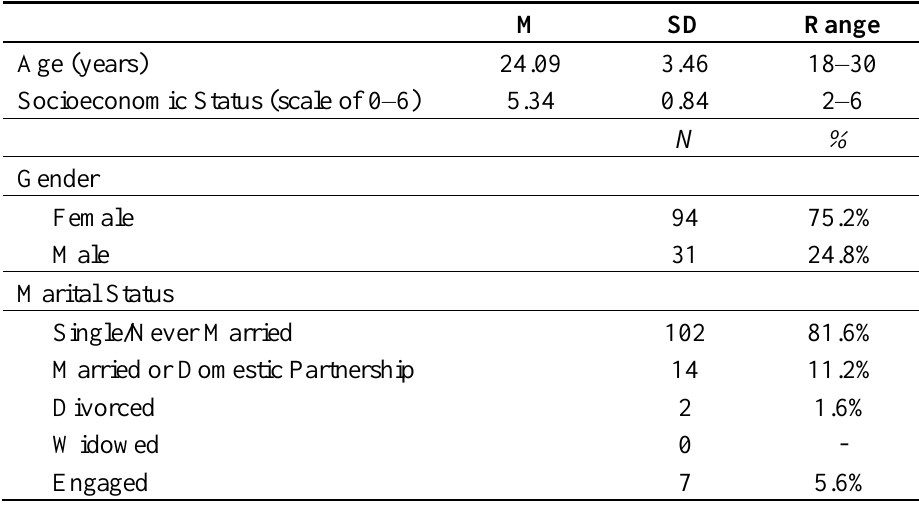
Table 1. Demographic characteristics of the